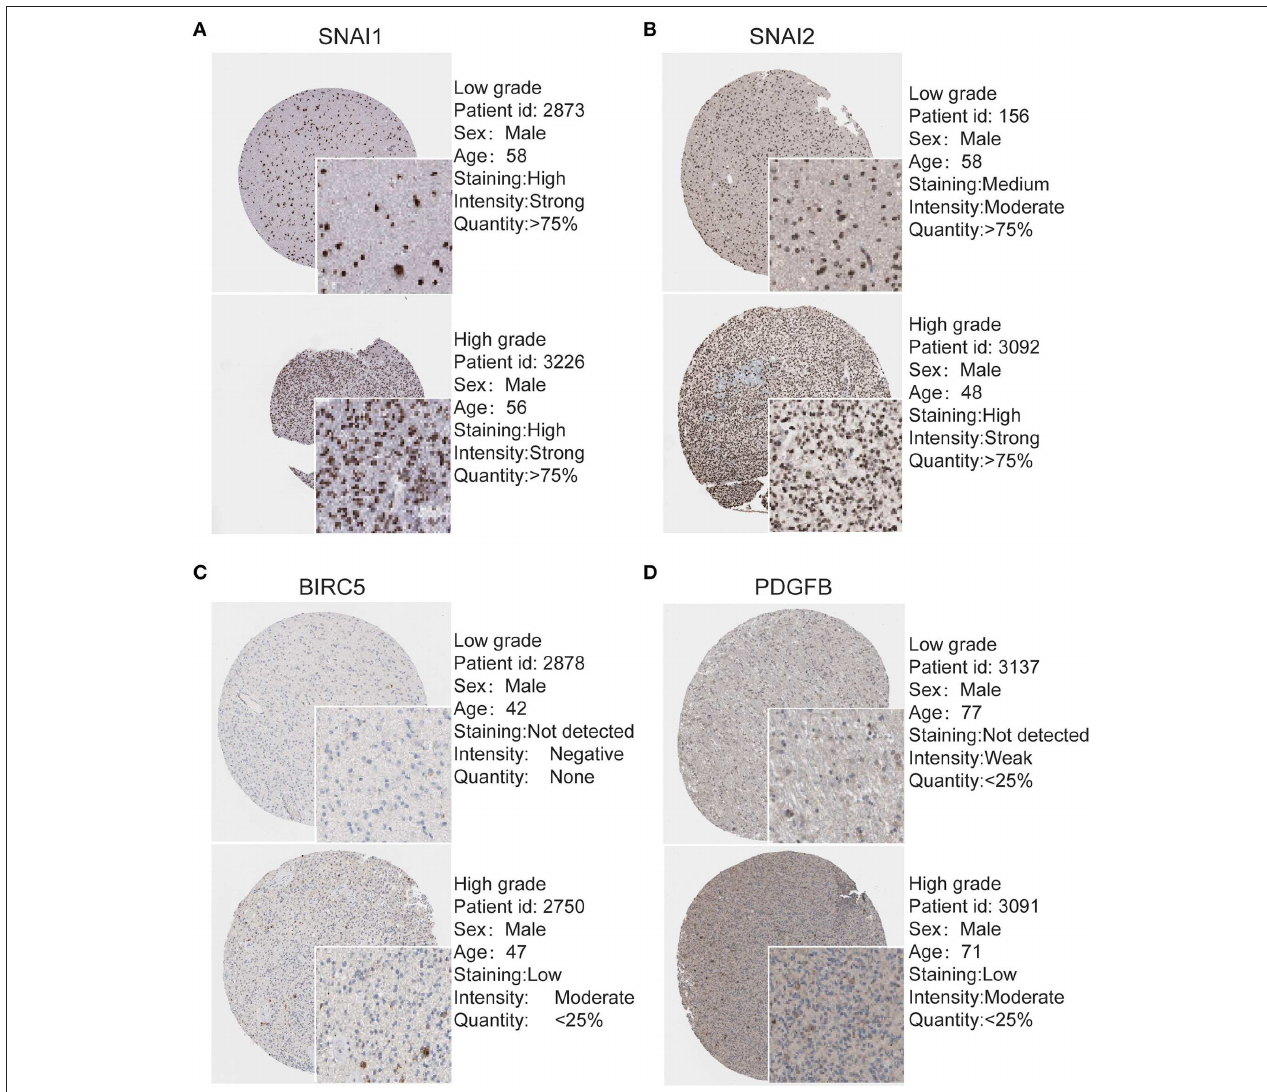
FIGURE 3 | Validation of Most significantly EMT related genes in the turquoise module by The Human Protein Atlas database (IHC) (A–D) . There were no related IHC samples of CXCR4 and TWIST1 in the database. The translational expression level of the four EMT related genes was positively correlated with disease status as they were upregulated in glioma